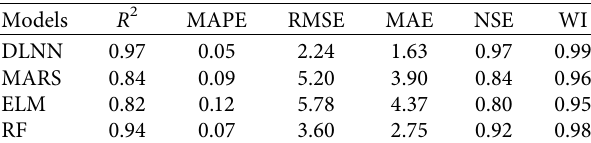
Table 8: Statistical measurements for the developed AI model across the testing phase for 90-10% data division